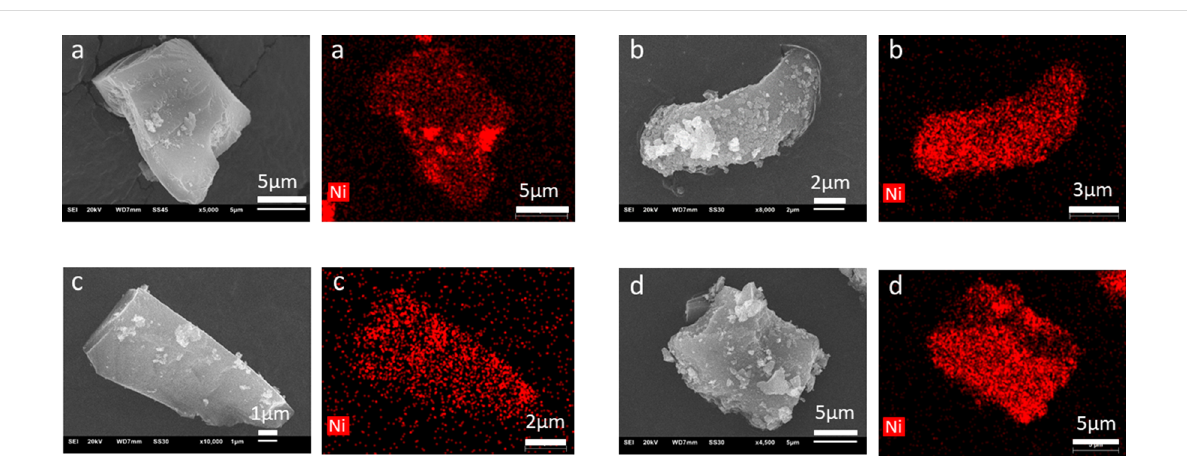
Figure 3: SEM images and EDX elemental mappings of Ni for (a) Ni/CTF-1-400-20, (b) Ni/CTF1-400-35, (c) Ni/CTF-1-600-22 and (d) Ni/CTF-1-600- 33. Ni atoms are depicted in